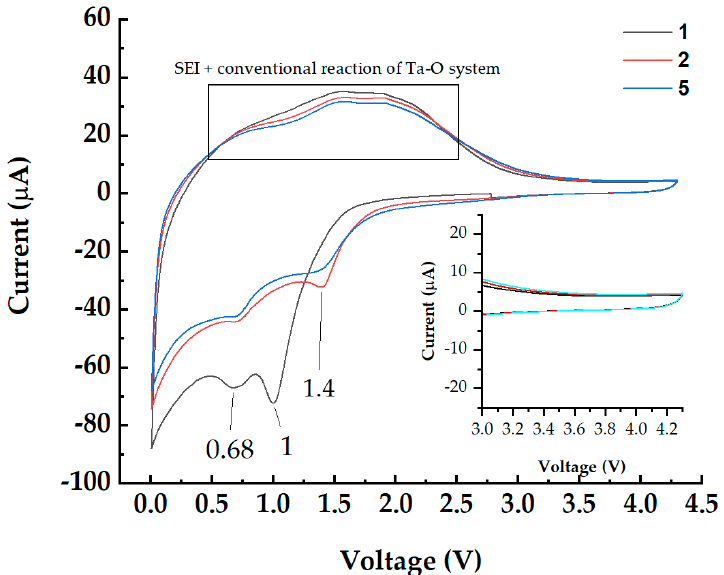
Figure 8. CV of coatings of the Ta-O system in the potential window of 4.3–0.1